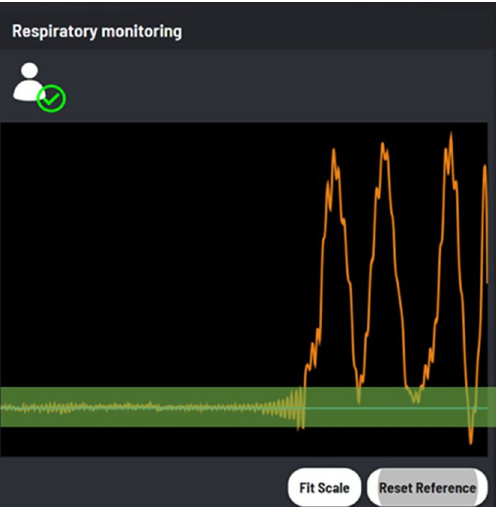
Figure 3. Screenshot of the respiratory monitoring function (home-made software). The orange line shows the live respiratory movement. When an apnea is performed, the curve stabilizes and a reference level can be defined (blue line). A gating threshold is also displayed as a green tube to help verifying apnea or breath-hold repeatability.